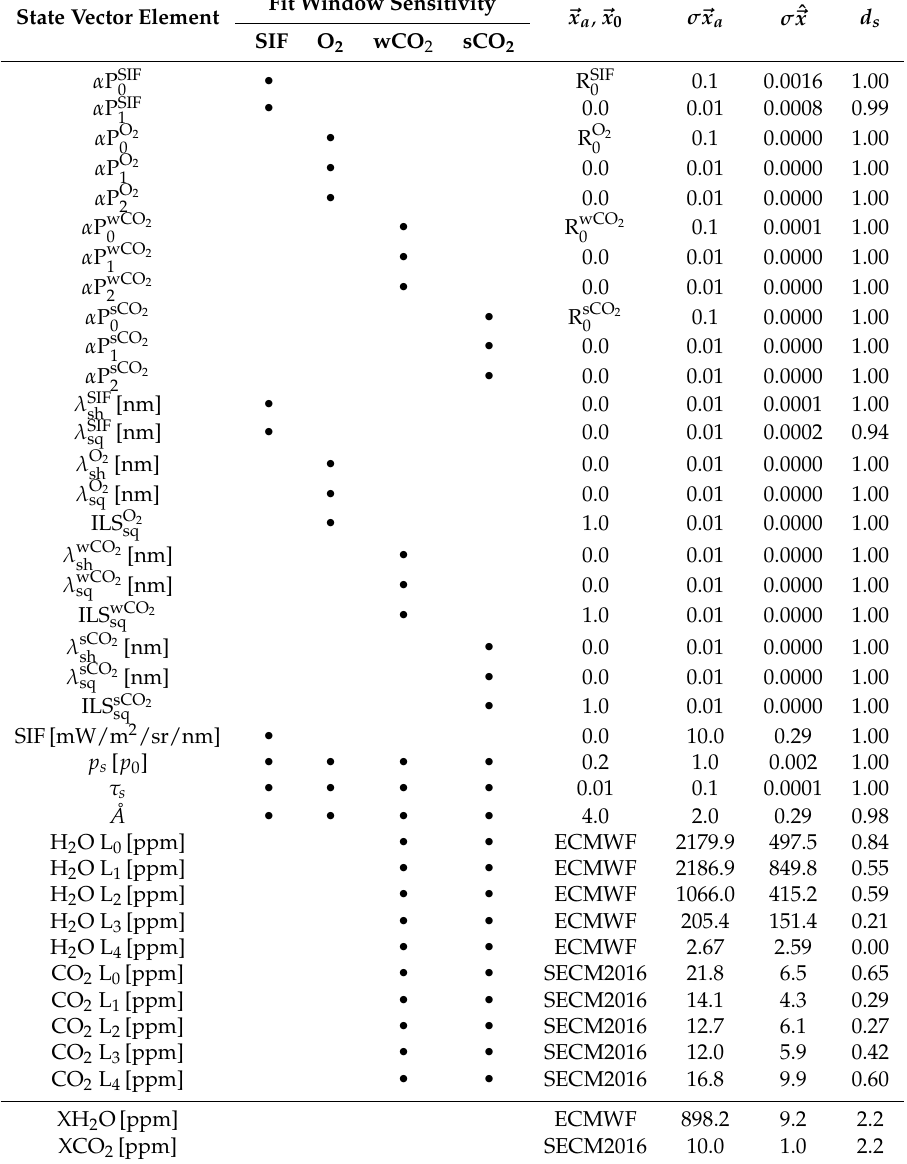
Table 1. State vector composition of the baseline, i.e., the 3-Scat retrieval setup (see Section3.2.1 for definition of retrieval setups). From left to right, the columns represent the name of the state vector element, its sensitivity within the four fit windows, a priori (cid:126) x a and first guess (cid:126) x 0 value, the a priori uncertainty σ (cid:126) x a , the a posteriori uncertainty σ ˆ (cid:126) x , and the degrees of freedom d s . A posteriori uncertainty and degrees of freedom represent results of the geophysical Rayleigh scenario, θ 0 = 40°, and perpendicular